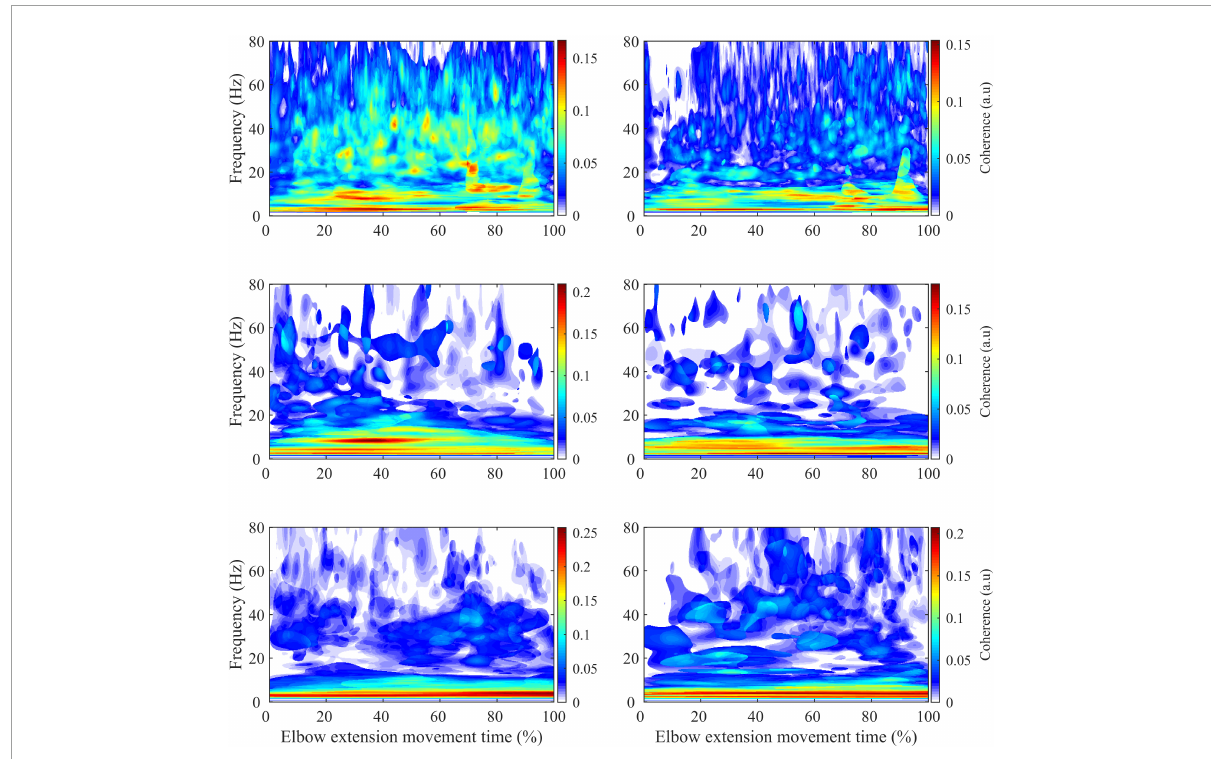
FIGURE6 Average intermuscular coherence map for the biceps brachii-brachioradialis (left) and triceps brachii-brachioradialis (right) muscle pairs of the paretic limb (first row) and non-paretic limb of the stroke subjects (second row) and the dominant limb of the control subjects (third